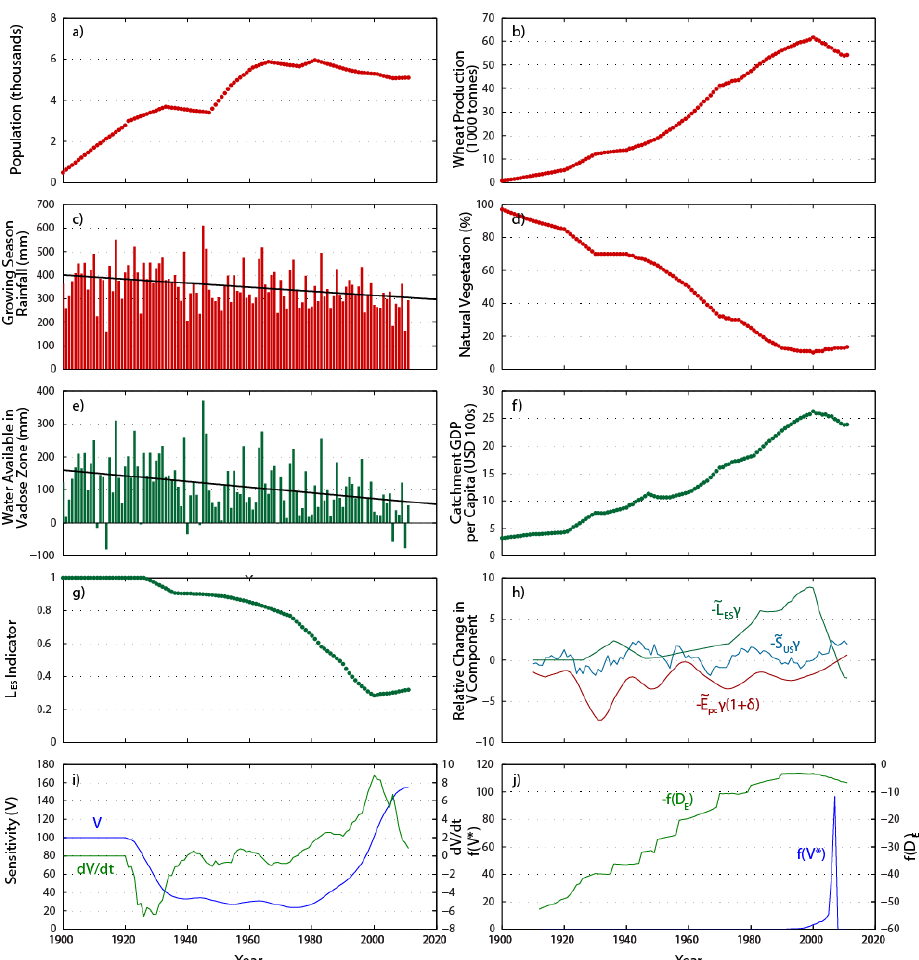
Figure 7. Stylised model data and results for an idealised rainfed catchment e.g. Lake Toolibin catchment. (a) Catchment population growth ( P n ). (b) Wheat production. (c) Growing season rainfall (May–Sep). (d) Percentage of Natural deep rooted vegetation cover (A N ). (e) Growing season water availability stored in the vadose zone ( S US ). (f) Catchment GDP per capita ( E pc ). (g) Lumped “lifestyle” ecosystem services indicator ( L ES ). (h) Evolution of the three underlying catchment-component drivers of Sensitivity ( V ) over time. (i) Evolution of Sensitivity ( V ) and d V/ d t over time. (j) Evolution of behavioural response component functions, f (V ∗ ) and f (D E ) , over time (all data sources outlined in Table